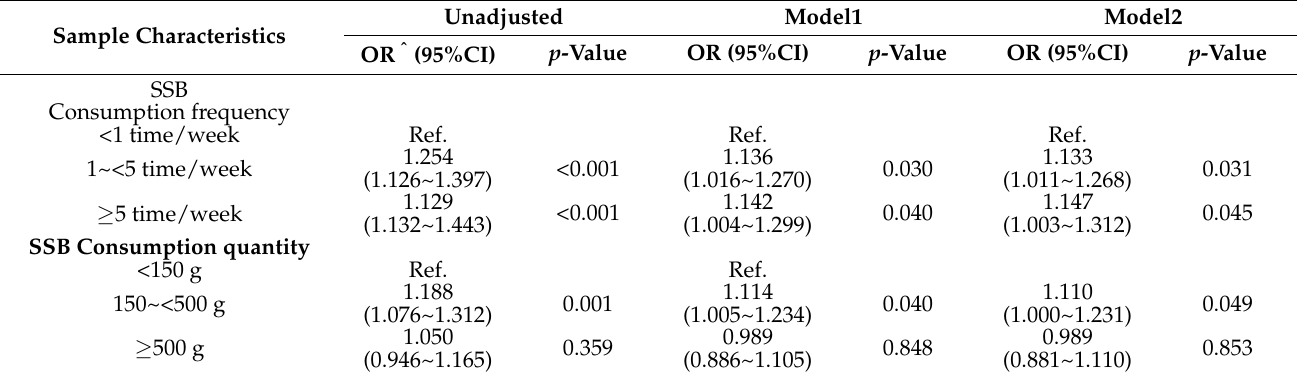
Table 5. Association of SSB consumption and status of overweight and obesity among Chinese 6–17-year-old children in 2012. Sample